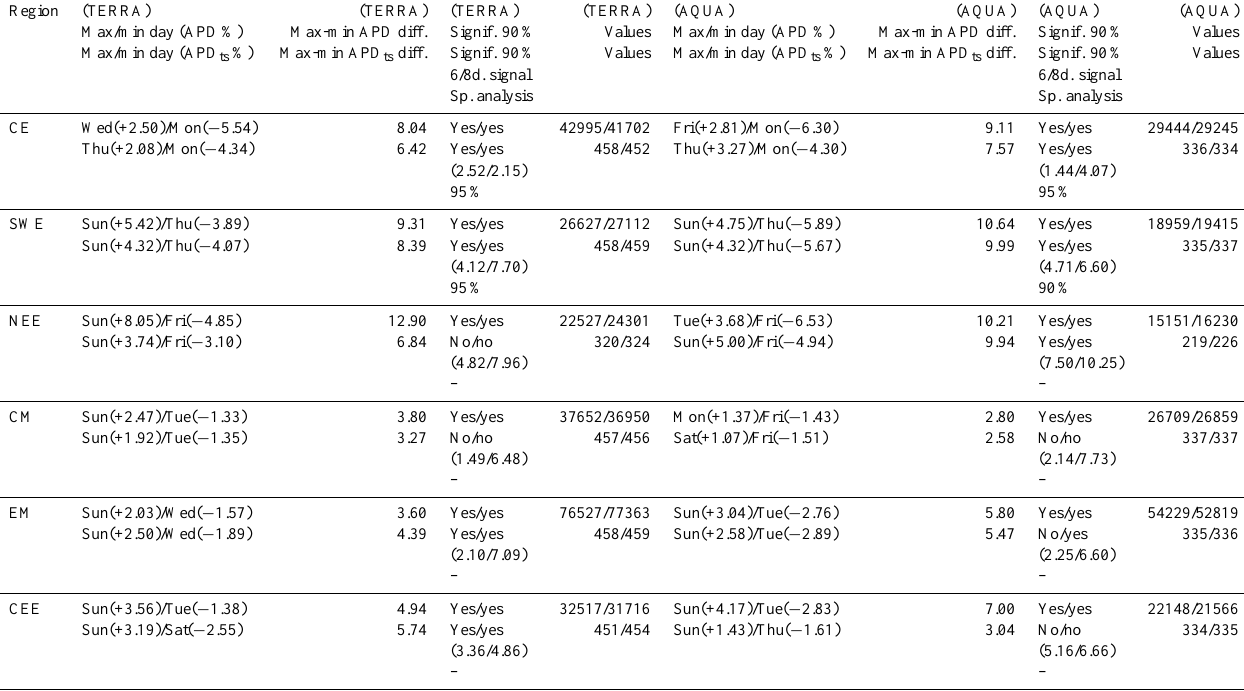
Table 2. Day of maximum and minimum average percent departure from the weekly mean calculated from the spatial analysis (APD) and the corresponding APD values, day of maximum and minimum average percent departure from the weekly mean calculated from the region time series (APD ts ) and the corresponding APD ts values, statistical significance at the 90% confidence level and the number of values included in the calculations, maximum and minimum APD calculated from the time series assuming hypothetical 6 and 8-day weeks, statistical significance of a 7-day cycle (90%/95% confidence level) indicated from the spectral analysis applied on the time series.